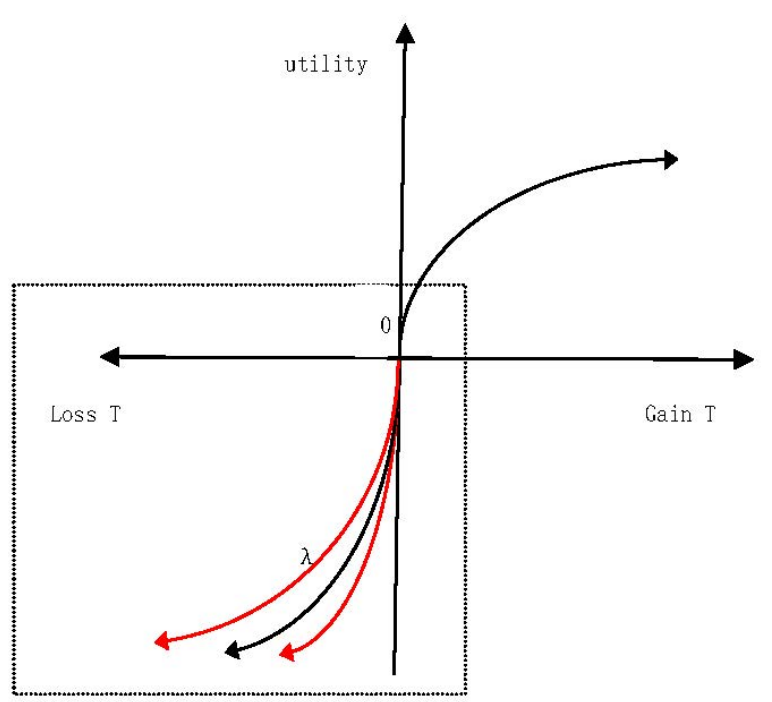
Figure 1. Perceived waiting utility of heterogeneous customers facing losses.